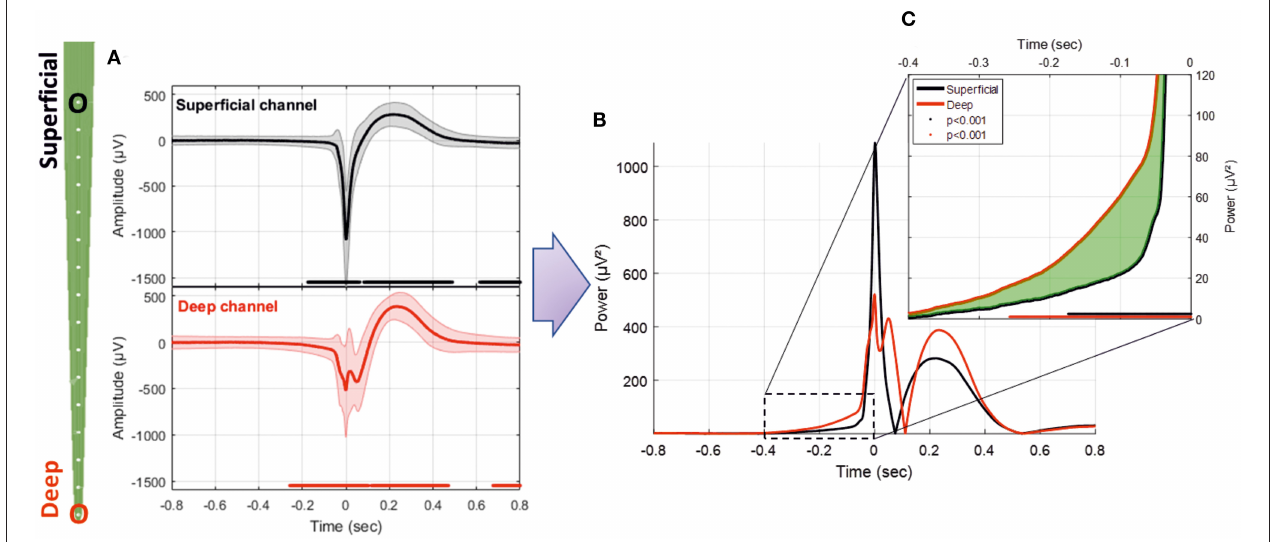
FIGURE 6 | (A) Average LFP for superficial and deep channels recorded with the MLE probe with an ISI of 1.5s (26,660 IISs). (B) Superposition of the average power of the superficial and deep channel signals. (C) Enlargement of the pre-spike period, highlighting the difference (in green) between the RMS signals of deep and superficial channels. The red and black solid lines indicate significant differences from the baseline for deep and superficial channels, respectively ( − 800 to − 600ms) ( p <